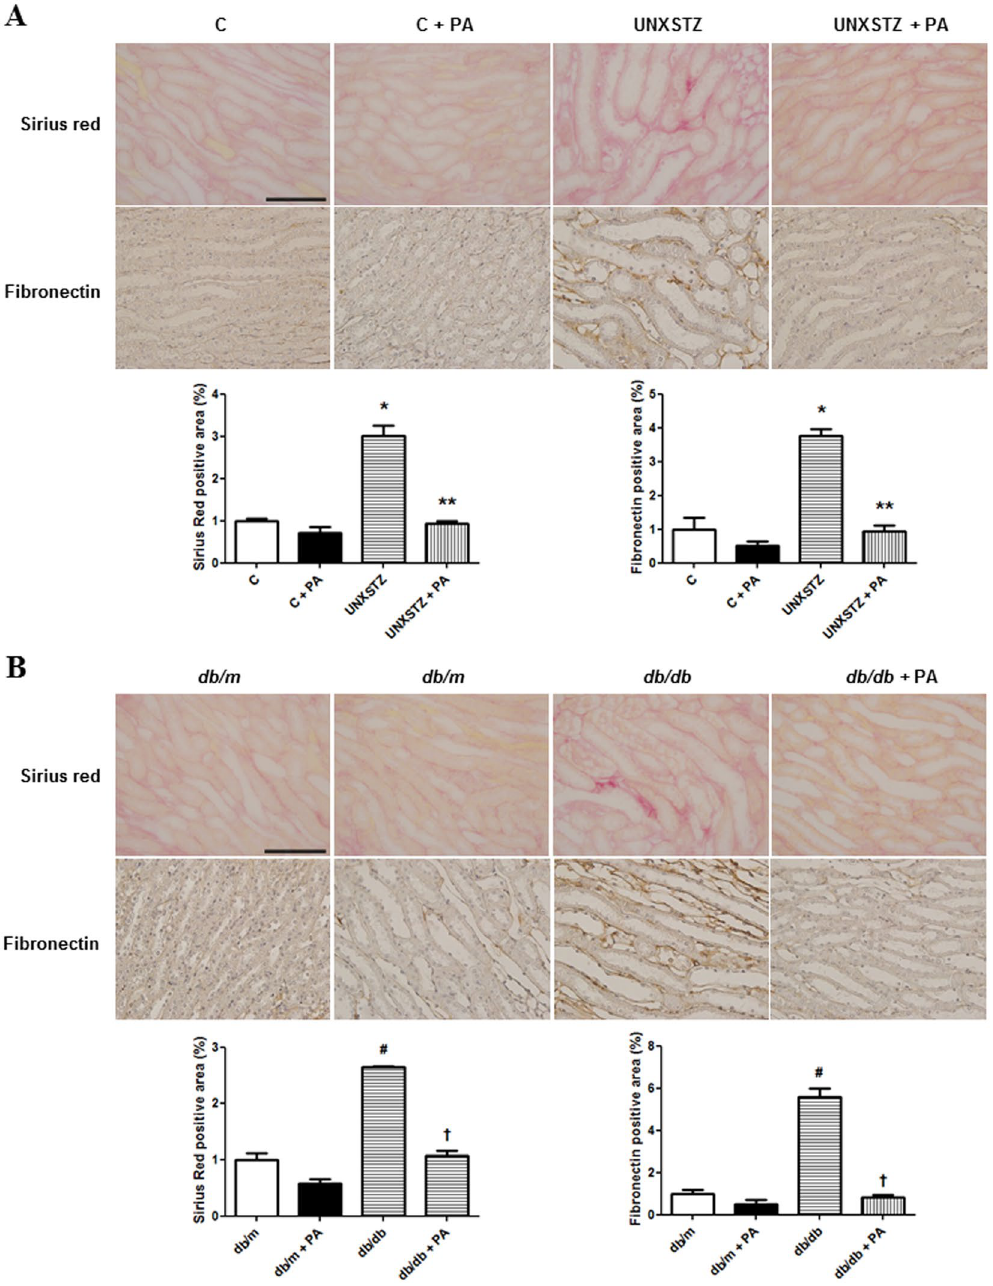
Figure 6. Immunohistochemical staining of fibronectin and Sirius Red staining in diabetes mellitus (DM) and non-DM mice treated with or without a periostin-binding DNA aptamer (PA). ( A ) Immunohistochemical staining and Sirius Red staining of the kidney revealed that renal fibronectin expression was significantly higher and renal fibrosis was more severe in uninephrectomized STZ-induced DM (UNXSTZ) compared with the control. ( B ) Renal fibronectin expression was significantly higher and renal fibrosis was more severe in db/db mice compared with db/m mice (scale bar, 50 μ m). These changes in the DM mice were significantly attenuated by PA treatment (500 µ g/kg/d) ( × 40). C, control; PA, periostin-binding DNA aptamer; UNXSTX, uninephrectomized STZ-induced DM mice. * P < 0.05 vs. C; ** P < 0.05 vs. UNXSTX; # P < 0.05 vs. db/m ; † P < 0.05 vs. db/db